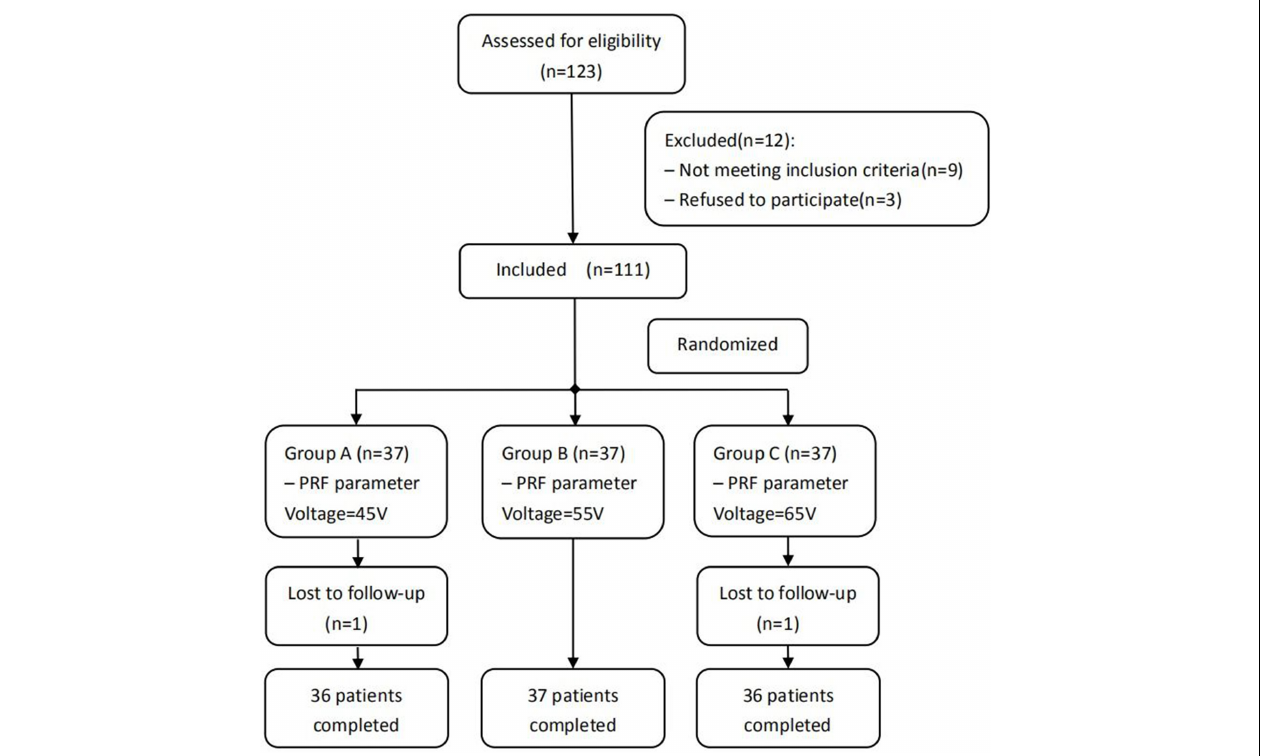
FIGURE 1 | Schematic illustration of the study design. All 109 patients were included in the